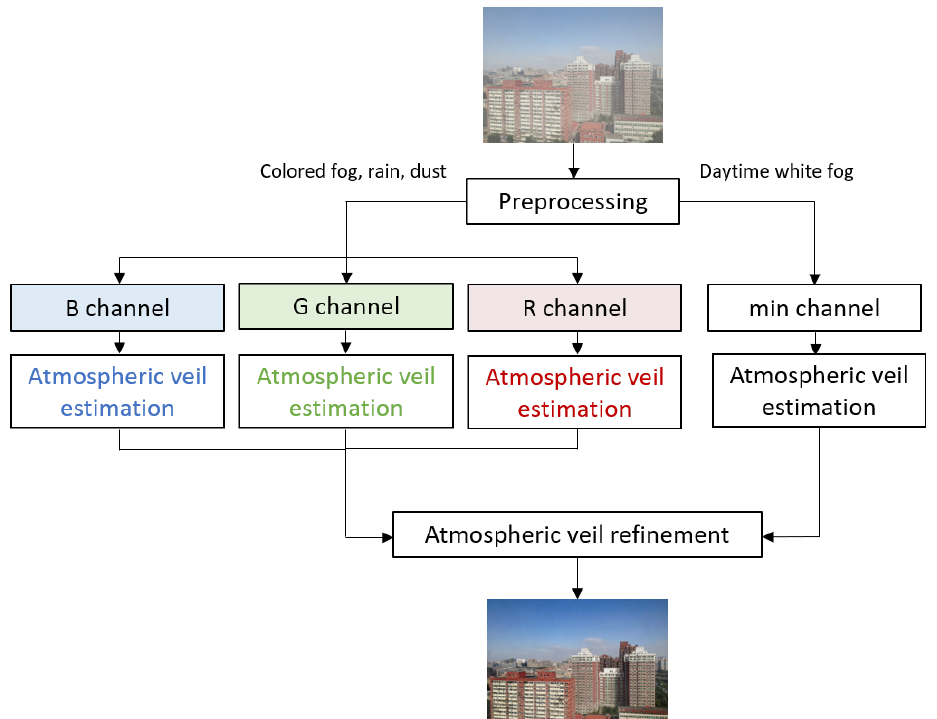
Figure 1. Flowchart of the proposed